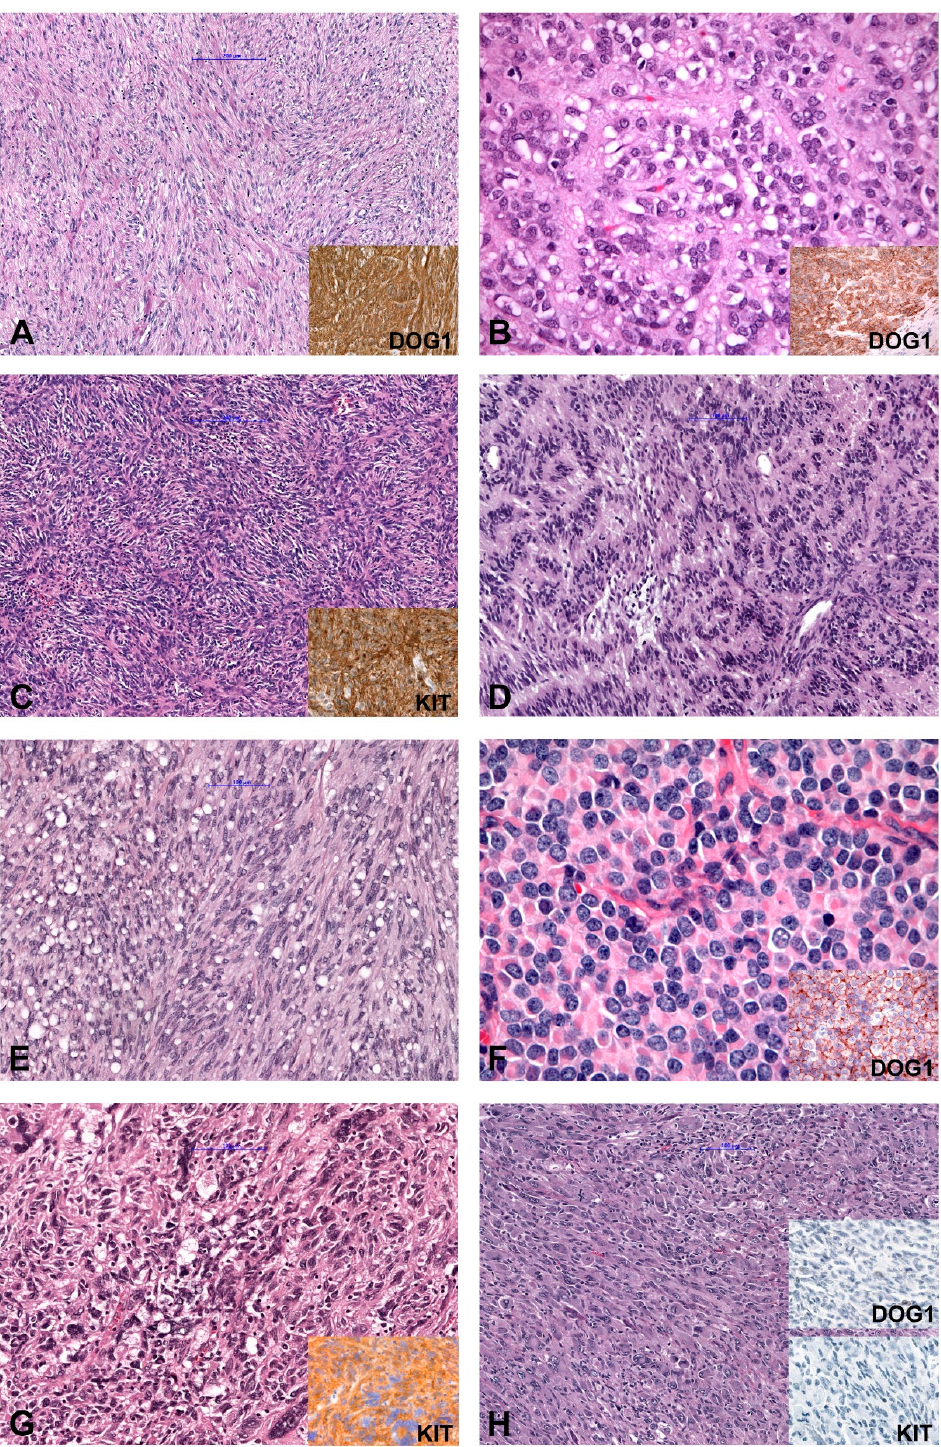
Figure 1. Morphology and immunohistochemical findings in GIST (Gastrointestinal Stroma Tumor). ( A ) Spindle cell GIST (inset: IHC DOG1+). ( B ) Epithelioid GIST (inset: IHC DOG1+). ( C ) Spindle cell GISTs with nuclear palisading, ( D ) GIST with storiform growth pattern, and ( E ) GIST with prominent paranuclear vacuolation. ( F ) Epithelioid GIST with a prominent plasmacytoid morphology. ( G ) Pleomorphic GIST (inset: IHC KIT+). ( H ) Dedifferentiated GIST (inset: IHC DOG1 − and KIT − ). IHC (immunohistochemistry); − (negative); +(positive).